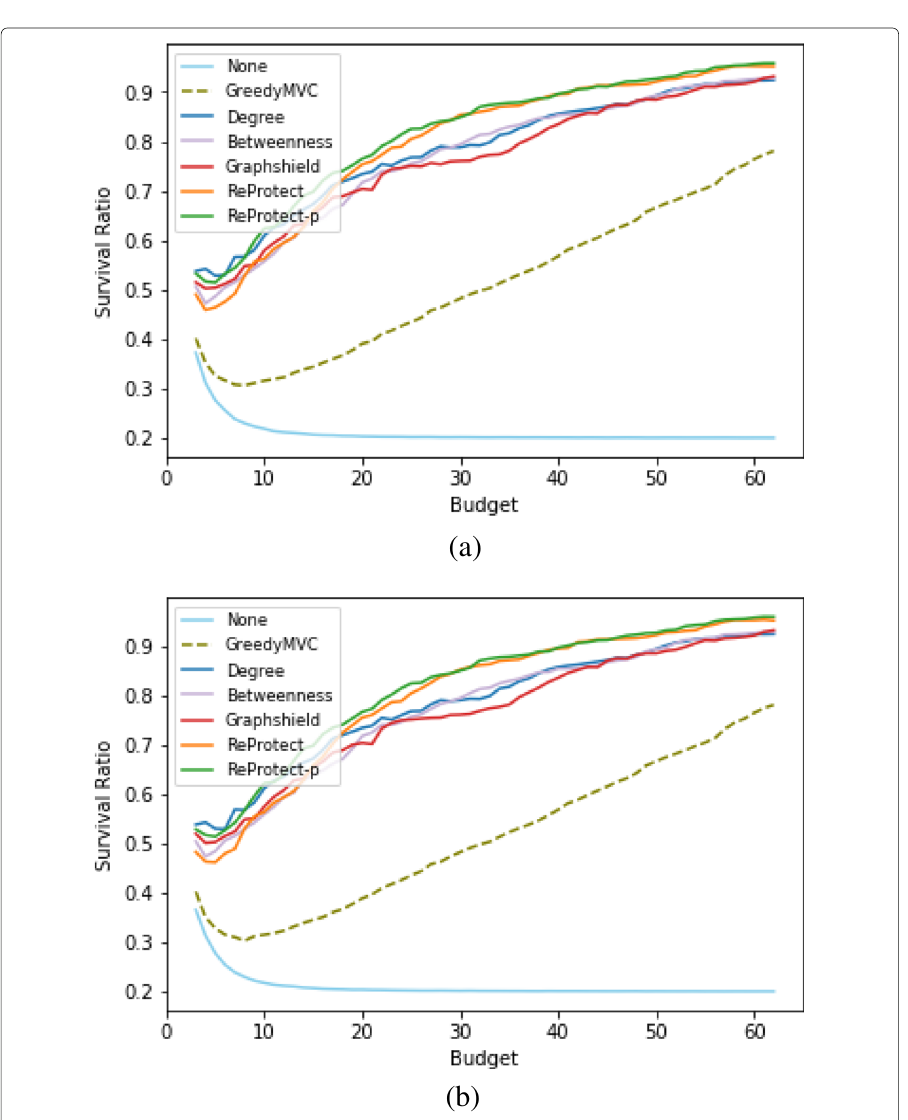
Fig. 5 Effectiveness evaluation on synthetic network. Both of our proposed methods (green and orange colored lines) outperform the other competitors. Higher is better. a SIS EpidemicModel. b SIR